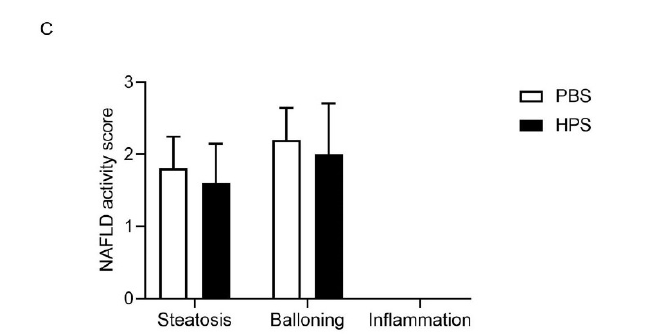
Figure 7. Effects of administration of HPS in lipid accumulation in wild type and ob/ob mice. Male C57BL/6J WT and ob/ob mice at 8 weeks of age were divided into two groups with one group receiving intraperitoneal injection of PBS and another group receiving HPS (1 mg/kg body weight) every day for 1 week ( n = 5/group). ( A ) Hepatic triglyceride levels were determined. ( B ) Liver tissues were fixed, sectioned and stained with H&E for histopathological and morphological analysis. Scale